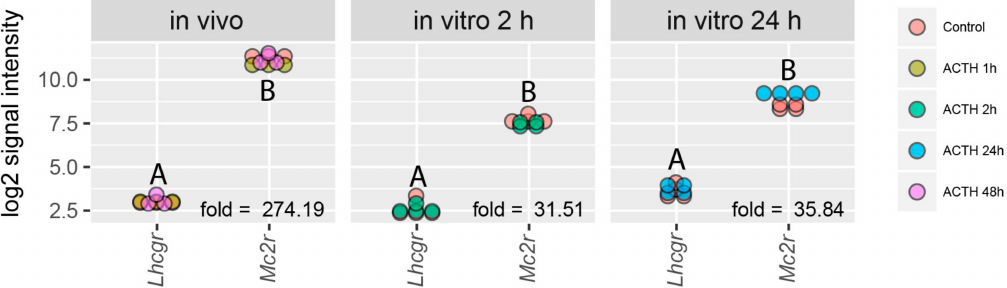
Figure 6. Expression of luteinizing hormone/choriogonadotropin receptor ( Lhcgr ) and melanocortin 2 receptor ( Mc2r ) in rat adrenals (in vivo—after i.p. ACTH injections) or in primary rat adrenocortical cells (in vitro 2 h, in vitro 24 h). Data extracted from normalized gene expression data set of Affymetrix Rat Gene 2.1 ST Array, presented as a dot plot in log2 signal intensity scale. Expression fold change was calculated in relation to Lhcgr gene. Statistical analysis of the data was performed by using one-way analysis of variance (ANOVA) followed by Tukey’s HSD test. Groups sharing the same letter are not significantly different according to Tukey’s HSD